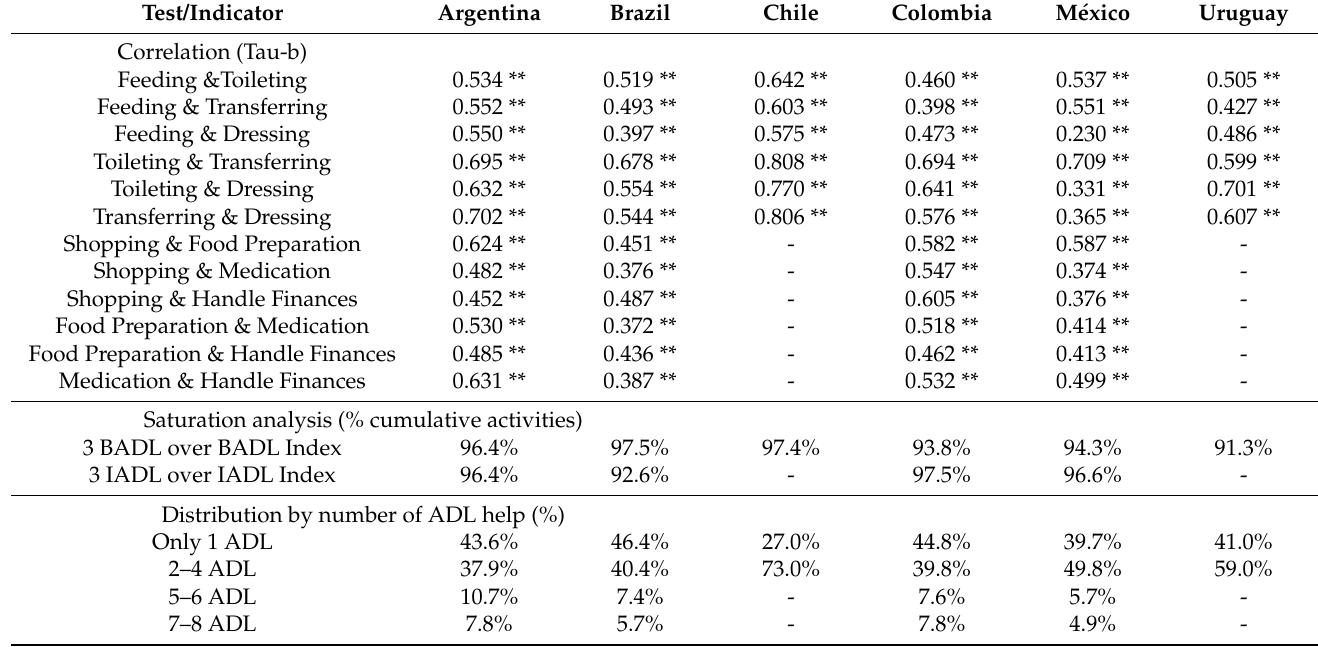
Table 8. Complementary